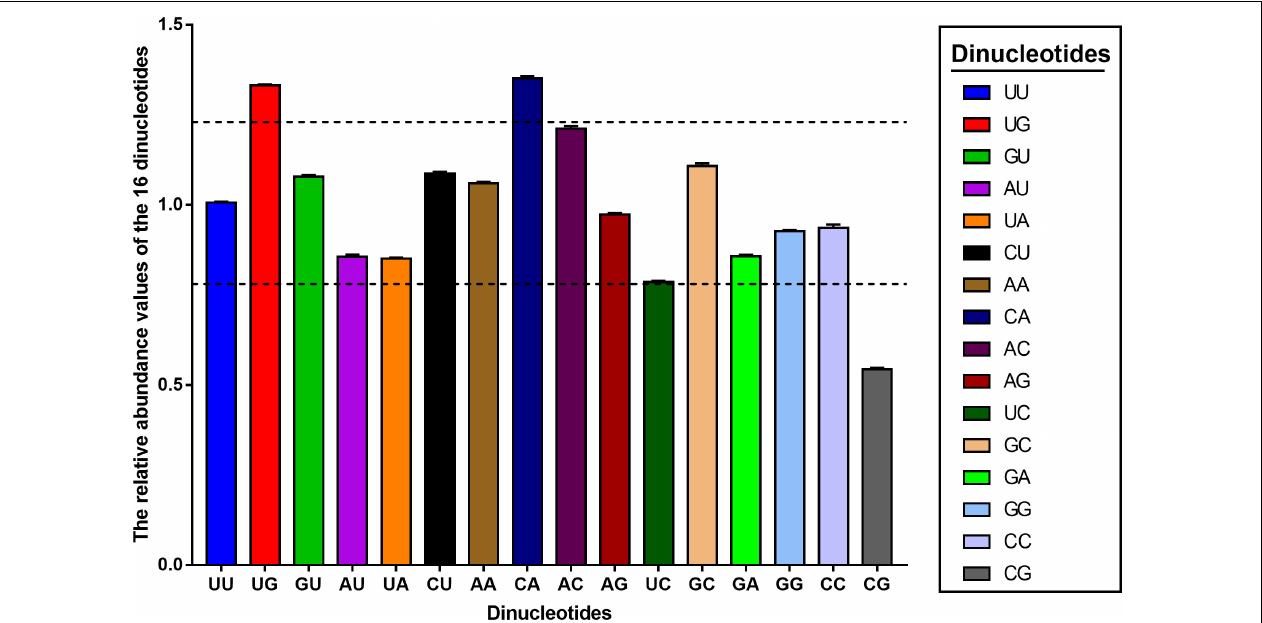
FIGURE 4 | The relative dinucleotide abundance values of the PEDV complete coding sequence. The different colors represent the different dinucleotides, the above and below dashed lines represent 1.25 and 0.78, respectively. Dinucleotides are regarded as under-represented or over-represented if the relative abundance values are below 0.78 or over 1.25 (dashed lines),